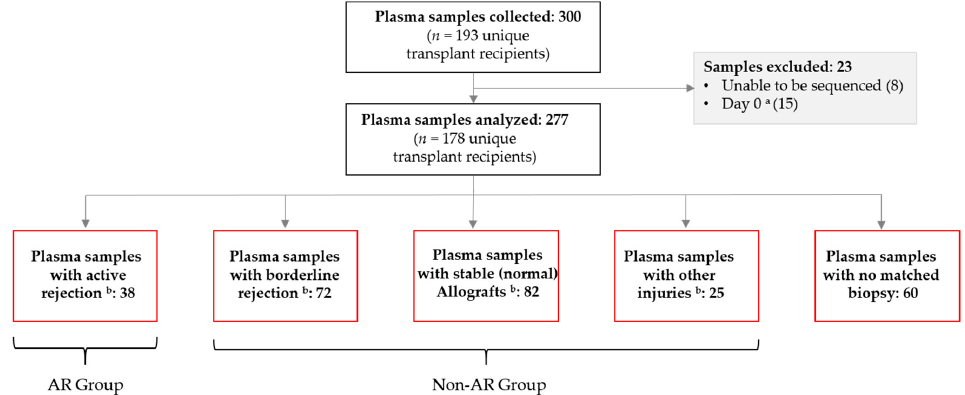
Figure 1. Plasma sample breakdown. AR, active rejection. a Collected within three days post transplantation; b samples drawn on the day of biopsy (i.e., were